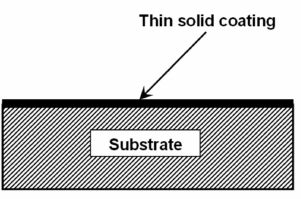
Figure 14. A typical system of thin, solid